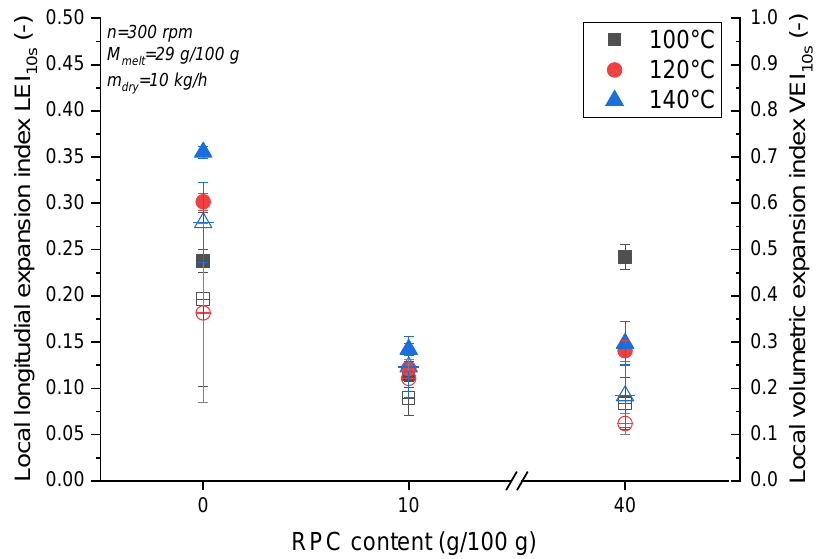
Figure 4. Effect of the barrel temperature (T Barrel = 100, 120 or 140 °C) and rapeseed press cake (RPC) content (0, 10 or 40 g/100 g (w.b.)) on maize starch (MS) extruded at 29 g/100 g (d.m.) moisture content. RPC is plotted against intermediate longitudinal expansion (LEI 10s , filled symbols) and intermediate volumetric expansion (VEI 10s , empty symbols).